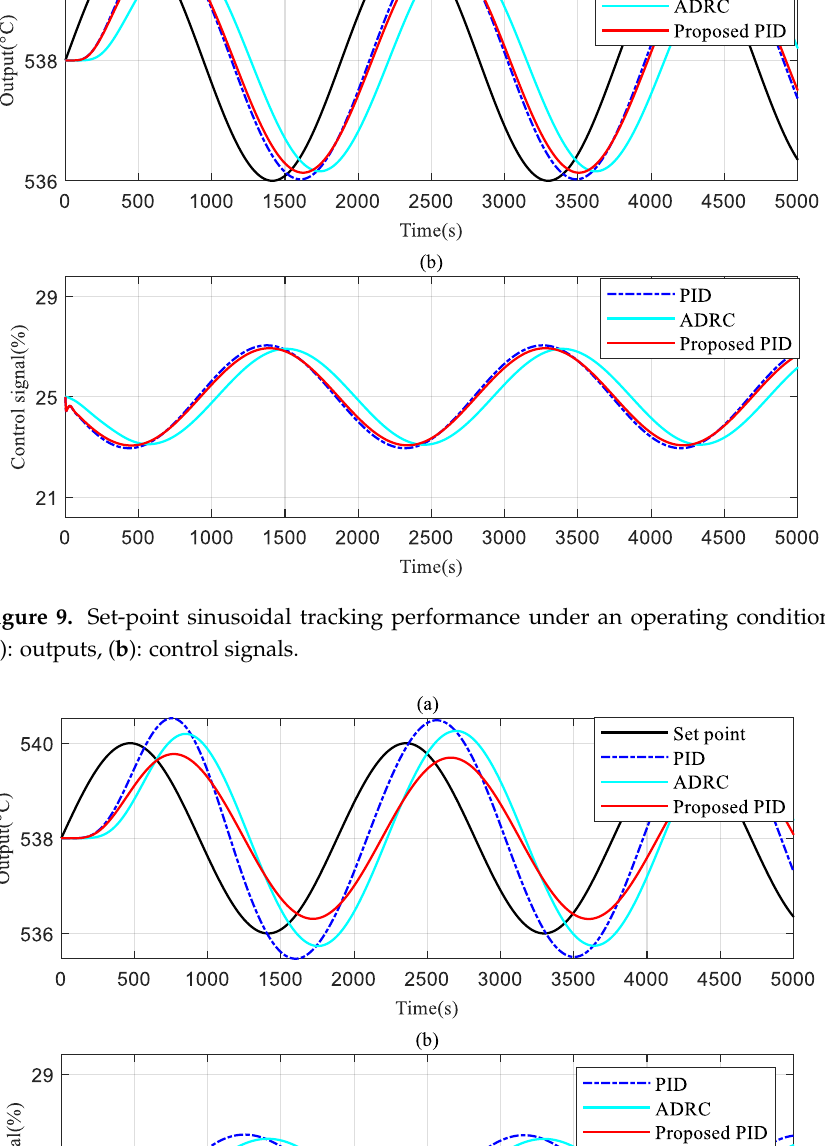
Figure 8. Set-point sinusoidal tracking performance under an operating condition of 100% load ( a ): outputs, ( b ): control signals.